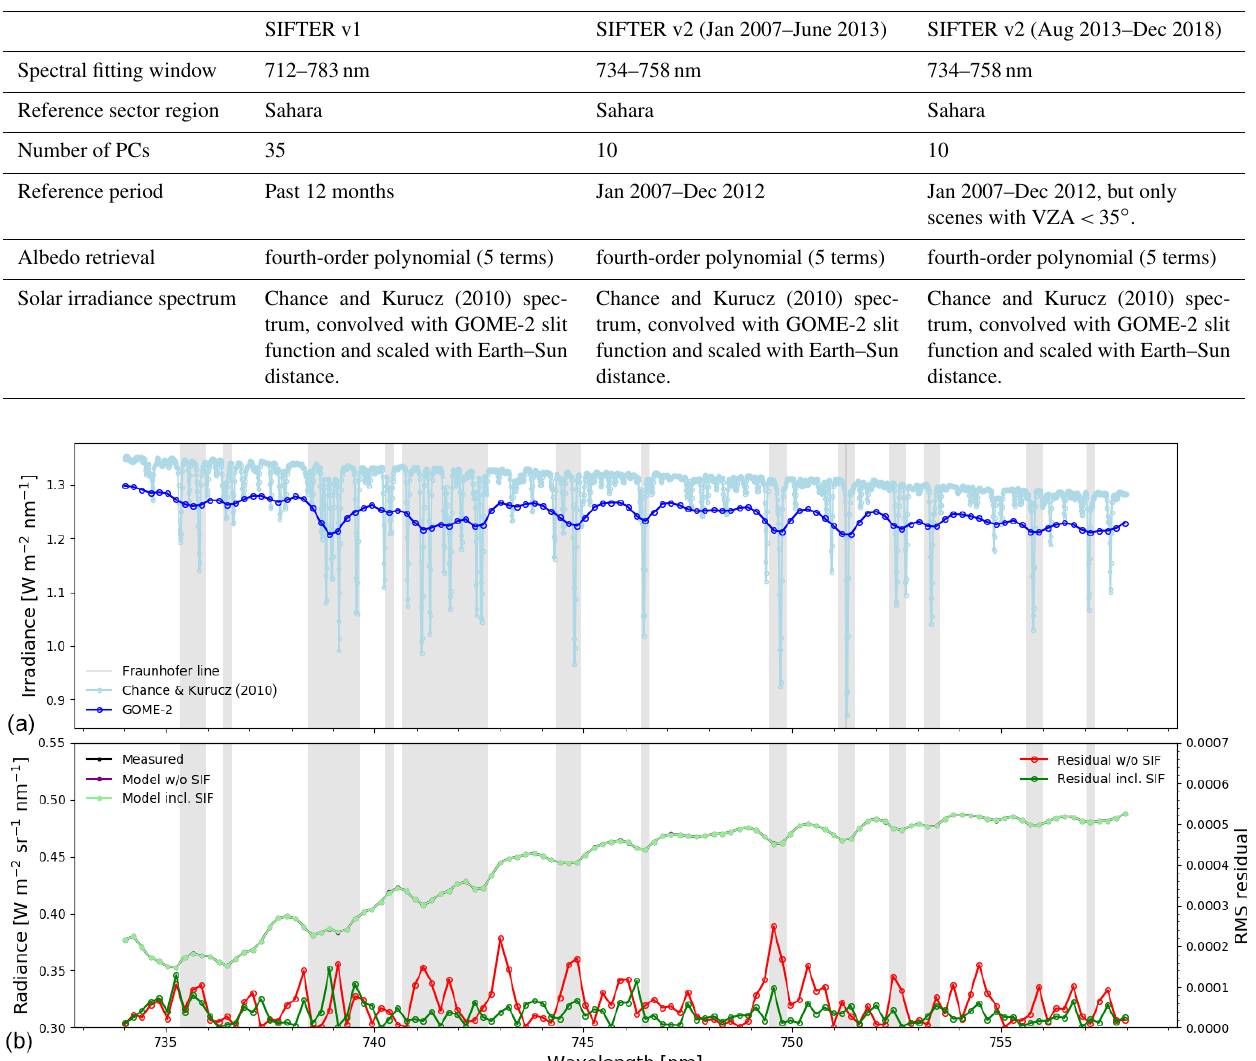
Figure 4. (b) The measured and modelled (with and without accounting for fluorescence) radiance spectrum in the SIFTER v2 fit window (734–758nm) on 15 July 2007 over vegetated areas in the eastern US (orbit 3821). The spectra represent the average over 378 cloud-free pixels with a fluorescence signal strength > 1 . 5mWm − 2 sr − 1 nm − 1 . The measured and modelled spectra are indistinguishable, and thus only the light green line is visible. The dark green and red lines show the absolute radiance residuals for a fit including and excluding fluorescence. Panel (a) shows the 0.01nm resolution solar irradiance spectrum in light blue (Chance and Kurucz, 2010) and the irradiance spectrum convolved with the GOME-2A slit function in dark blue. The grey lines connecting panels (a) and (b) indicate the spectral regions where the solar Fraunhofer line infilling by fluorescence is